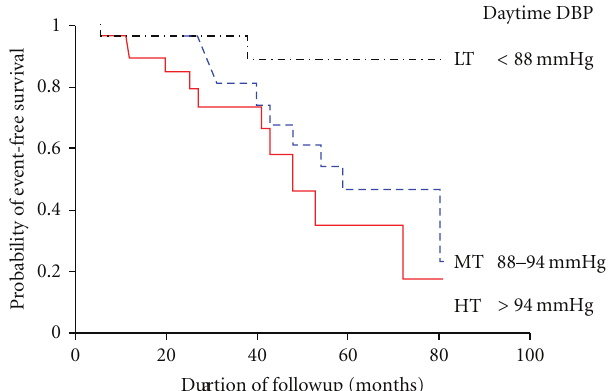
Figure 5: Probability of event-free survival in patients with resistanthypertension according to daytime diastolic blood pressure (modified from Redon et al.